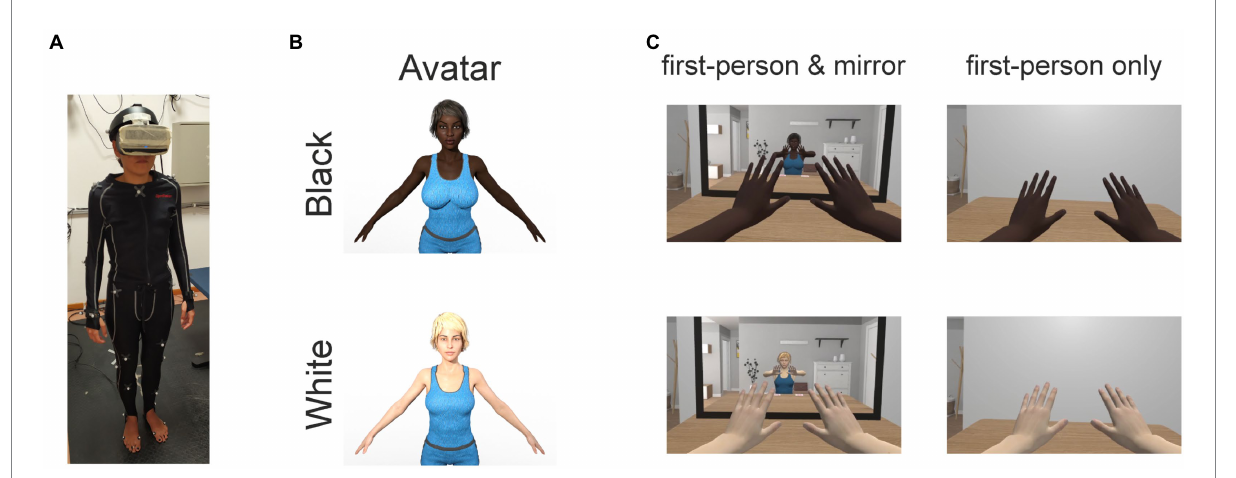
FIGURE 1 Experimental setup and conditions. (A) Motion capture suite with reflective markers and head-mounted display wore by participants in our experiments. (B) Photorealistic Black (upper row) and White (bottom row) avatars used in our experiments. (C) Experimental conditions. Participants in the “first-person and mirror” condition (left column) could see their virtual body both from a first-person perspective (i.e., by looking down toward themselves) and reflected in a mirror placed in front of them in the VR environment. Participants in the “first-person only” condition (right column) could see their virtual body only from a first-person perspective (i.e., by looking down toward themselves) as no mirror was placed in the VR environment (right